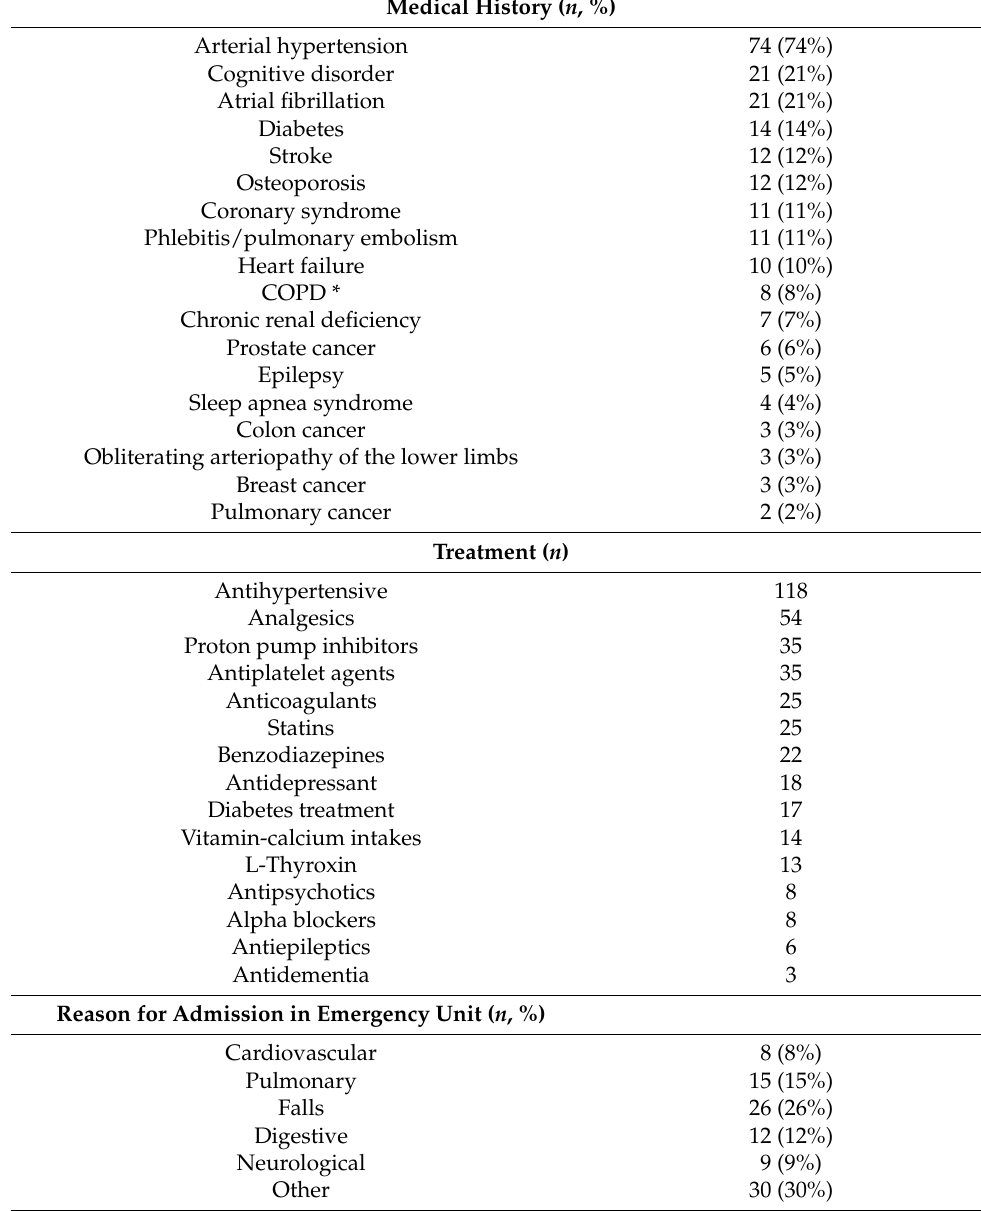
Table 2. Characteristics of the study population admitted in emergency unit ( n =